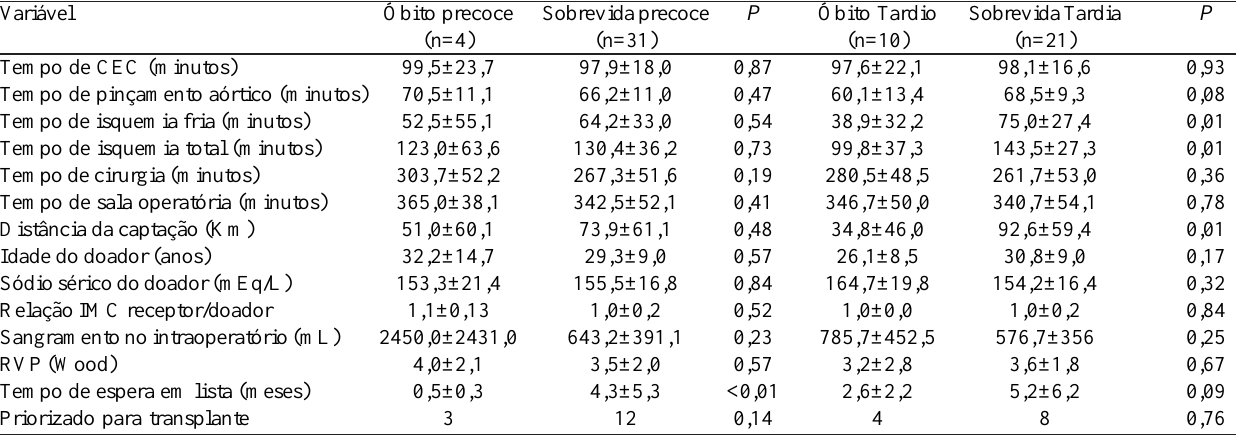
Tabela 2. Análise univariada para sobrevida precoce e tardia.